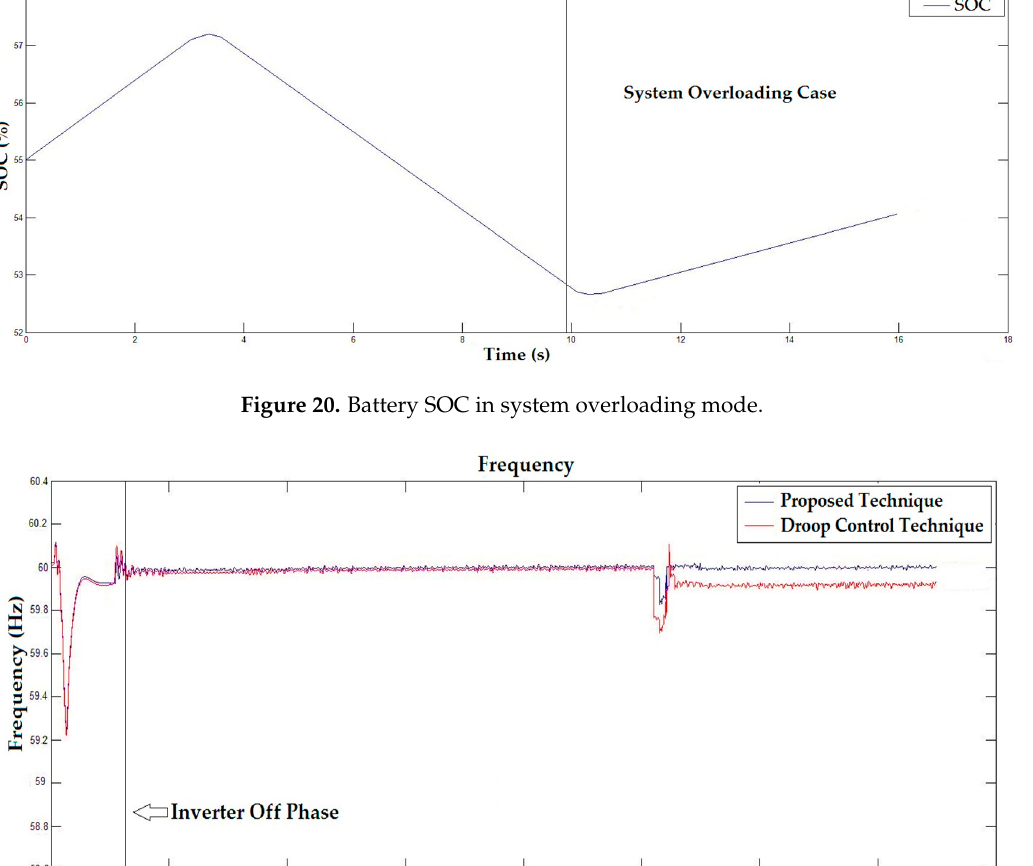
Figure 21 . Frequency response comparison of between proposed control system and conventional droop control method.